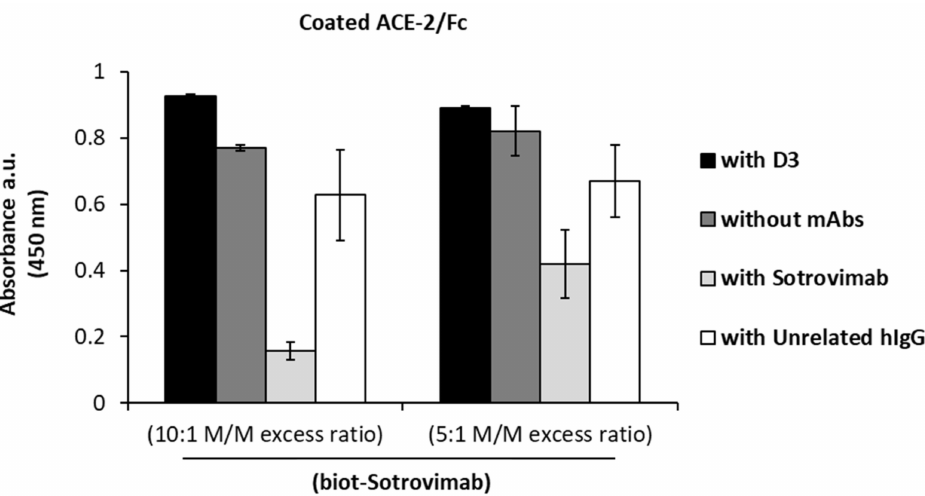
Figure 6. Competitive ELISA assays of D3 or Sotrovimab with Biotinylated Sotrovimab (biot- Sotrovimab). The ELISA assays were performed by pre-incubating the ACE-2 coated plate with RBD-SARS-CoV-2/His chimeric protein. The binding of the biot-Sotrovimab to RBD protein was measured in the absence of mAbs (dark gray bars) or in the presence of unlabeled-D3 (black bars), Sotrovimab (light gray bars) or unrelated (white bars) mAb (used at saturating concentration of 150 nM).